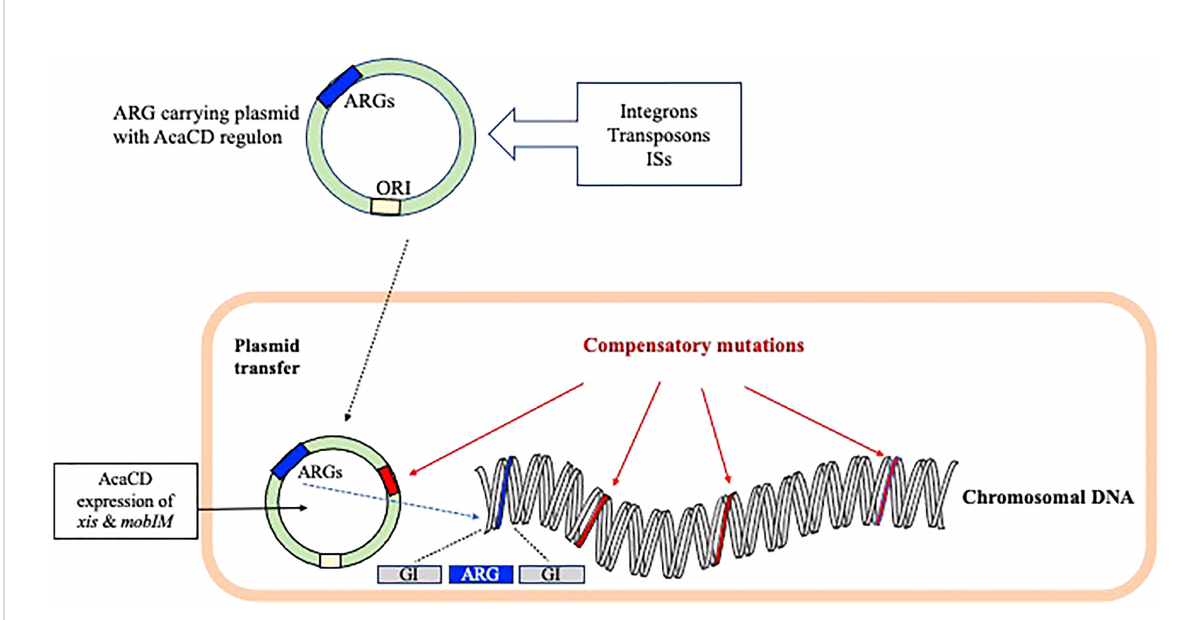
FIGURE 2 The role of plasmid and genomic island-encoded factors in the spread of AMR encoding genes. The mobility of selective Inc conjugative plasmid carrying the ARGs depends mostly on the master activator AcaCD regulon. The AcaCD supported expression of xis and mobIM helps in the excision and mobilization of AMR encoding genes, respectively. The fi tness costs in bacteria has been minimized through plasmid/ chromosomal compensatory